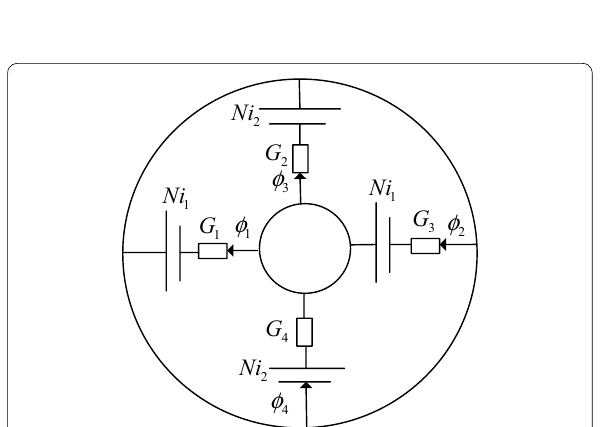
Figure 7 Equivalent magnetic circuit of radial control magnetic